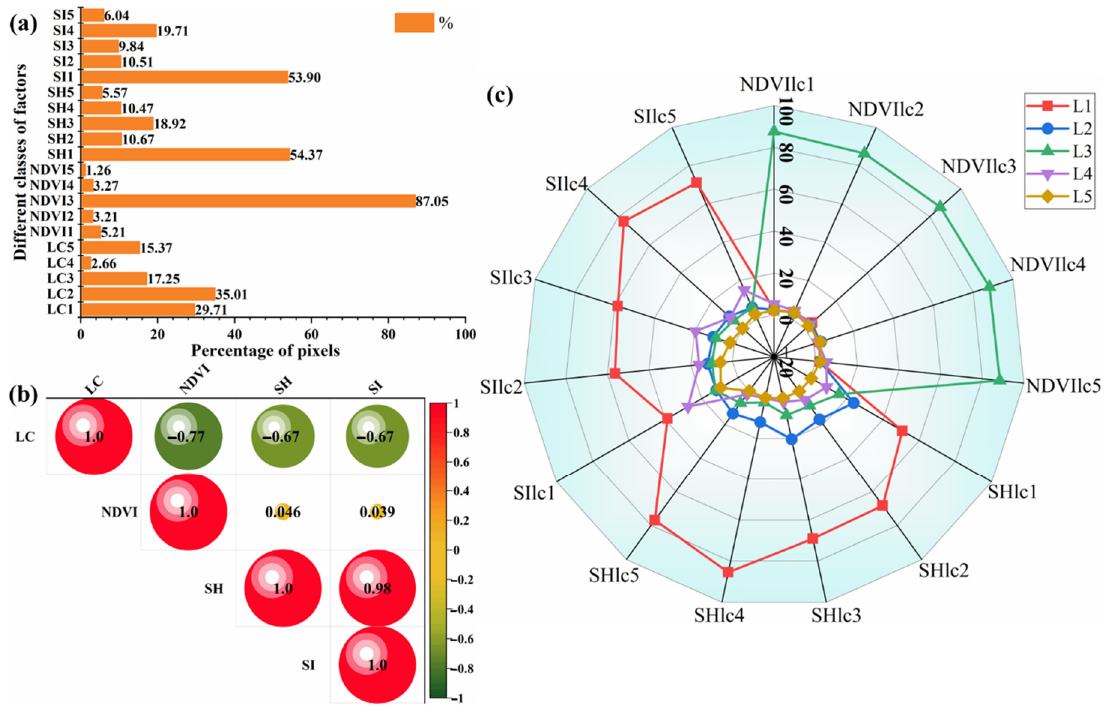
Figure 6. The classification results from the identification indicators: ( a ) the percentage of pixels in LC, NDVI, SH and SI at the five levels; ( b ) the spatial correlation of the four factors; ( c ) the percentage of pixels in NDVI, SH and SI at the five levels of LC (i.e., built-up areas (L1), intensive farmland (L2), woodland and grassland (L3), water bodies (L4) and semi-natural vegetation (L5)).